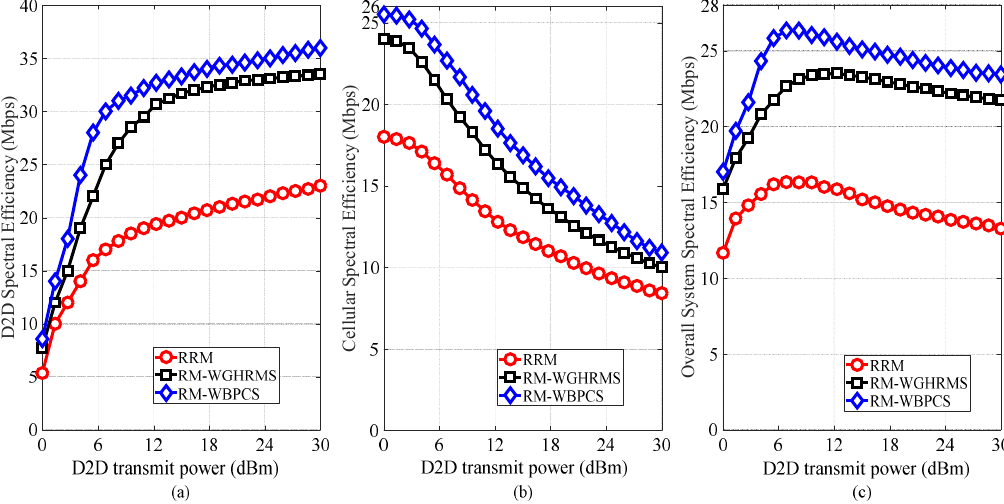
Figure 8. Spectral efficiency analysis with varying transmit power consumption of D2D for ( a ) DPs, ( b ) CUs, and ( c ) overall system.